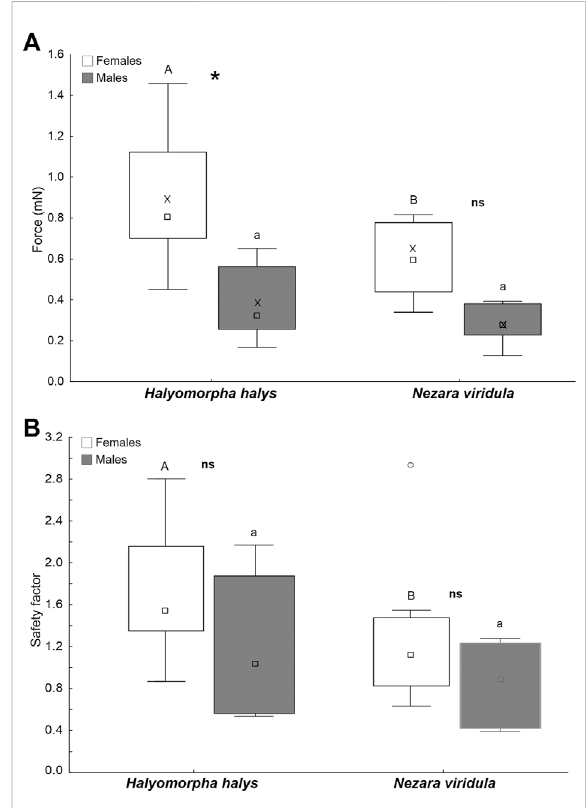
FIGURE 11 Pull-off force (A) andsafetyfactor(the forcedividedbyinsect weight) (B) of A. bifasciatus females and males on the egg surface of H. halys and N. viridula . Boxplots show the interquartile range and the medians, whiskers indicate the 1.5 × interquartile range and “ ° ” shows outliers. Boxplots with different upper case letters and lower case letters, respectively, are signi fi cantly different at p < 0.05. In the comparison between females and males, the asterisk (*) means signi fi cant difference at p < 0.05 and ns means not signi fi cantly different (Tukey unequal N HSD post hoc test, Repeated measures one-way